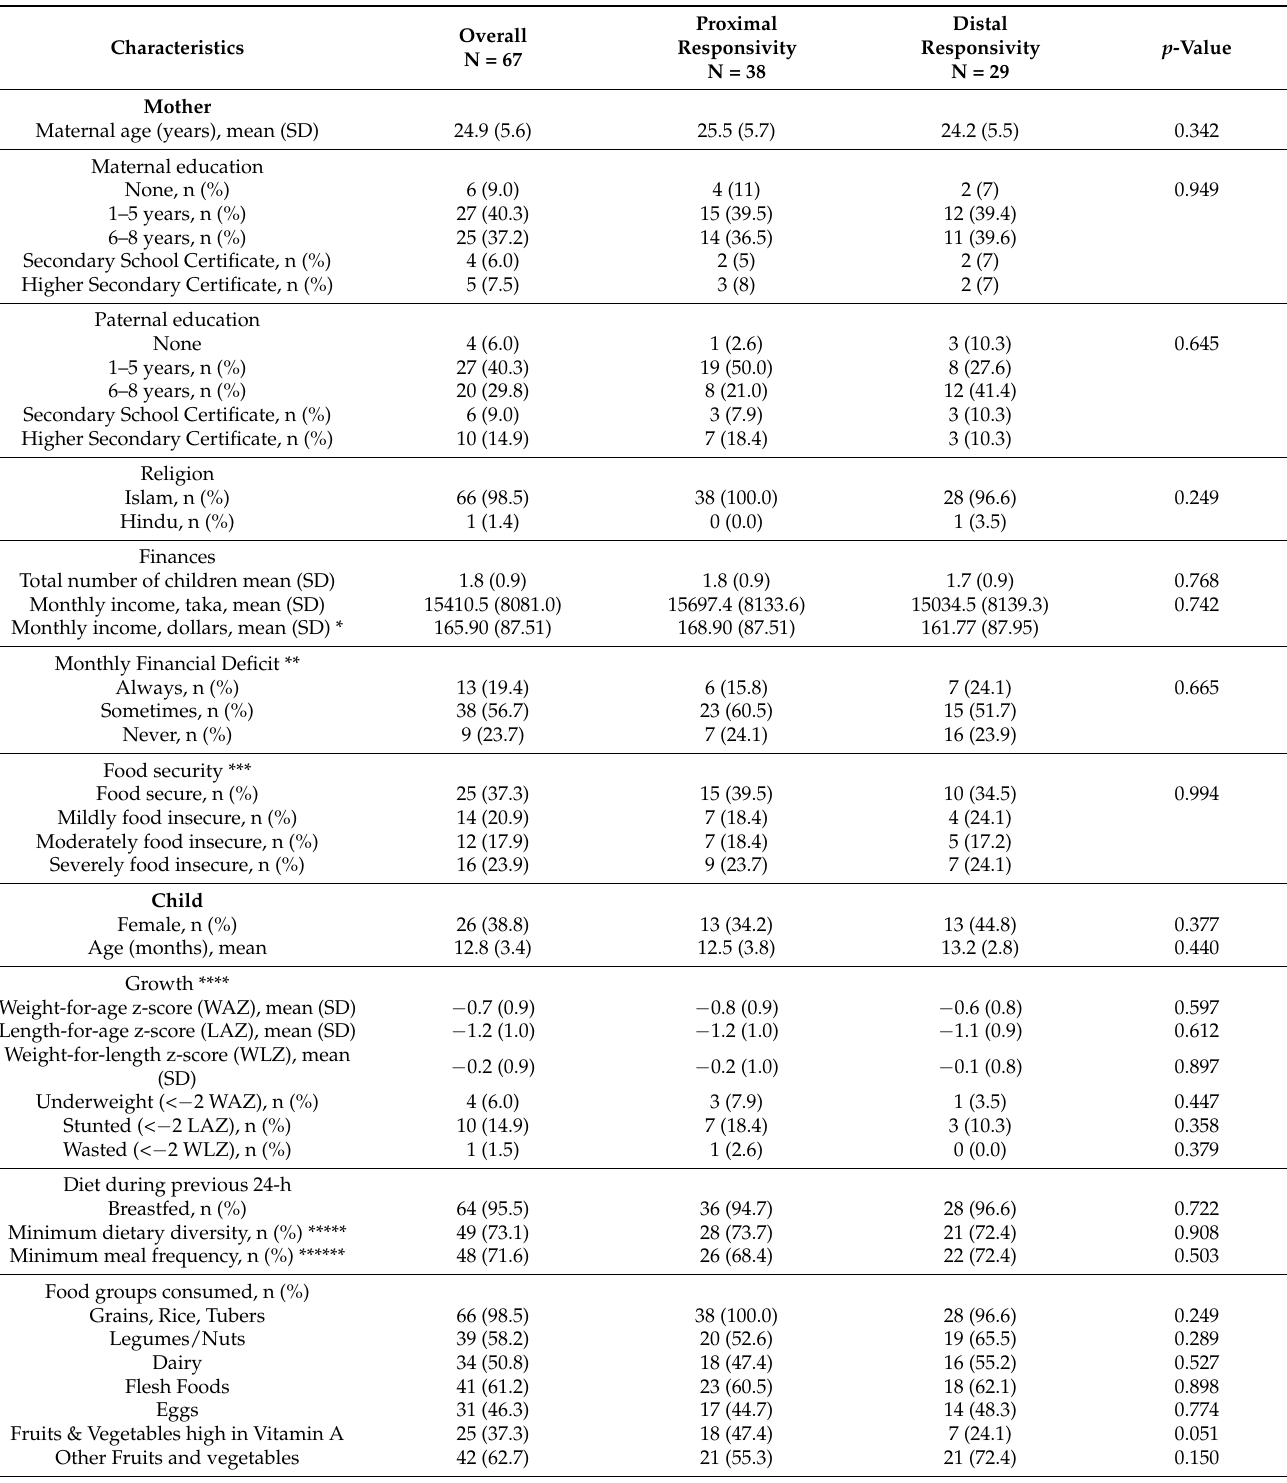
Table 1. Demographic and household characteristics of mother-infant dyads by proximal and distal